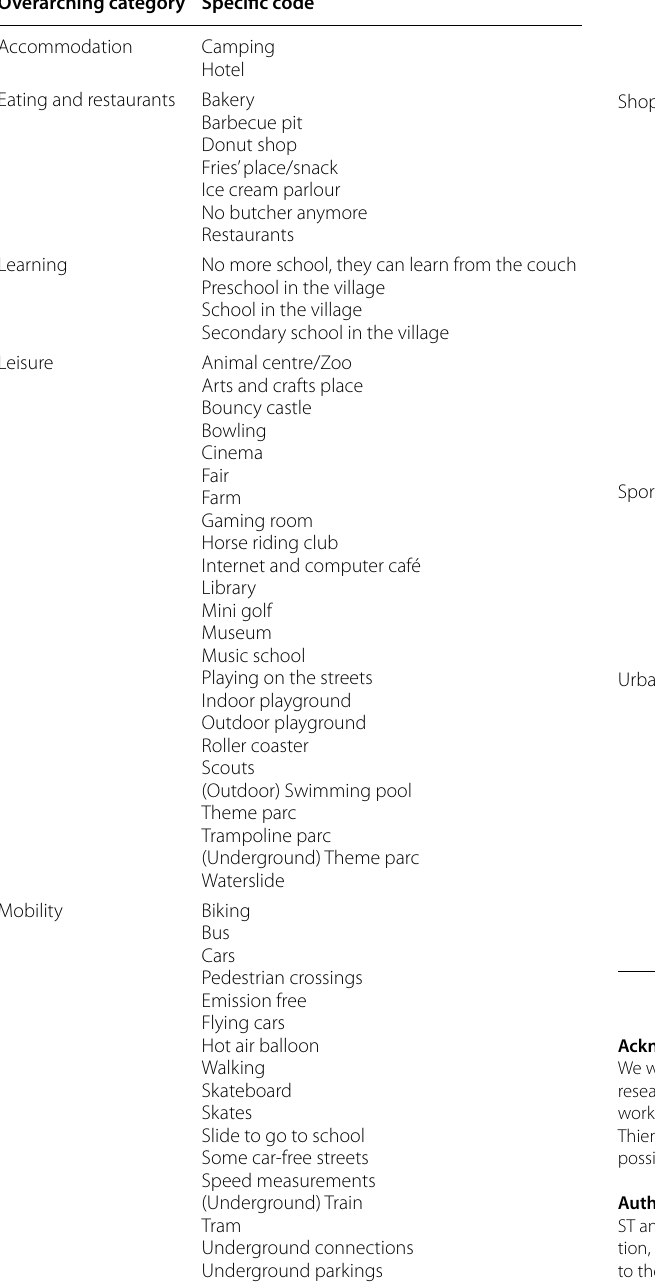
Table 5 Overview of the children’s ideas Overarching category Specific code